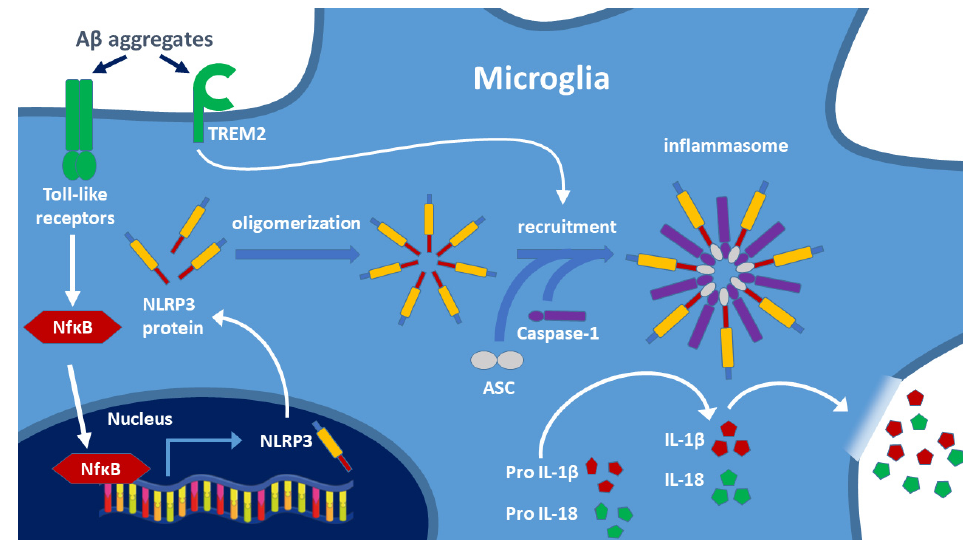
Figure 3. Two signals are involved in the formation of the NLRP3 inflammasome: activation of toll-like receptors (TLR) and TREM2 by toxic amyloid aggregates. Biosynthesis of the NLRP3 protein after NF- κ B induced gene expression results in oligomerization of the protein. Recruitment of caspase-1 and ASC generates the NLRP3 inflammasome, and caspase-1 cleaves the IL-precursor proteins leading to the release of mature cytokines IL-1 β and IL-18. These cytokines activate the cells of the immune system and trigger the inflammatory response, including the opening of the BBB. TREM2: triggering receptor expressed on myeloid cells 2; ASC: adapter